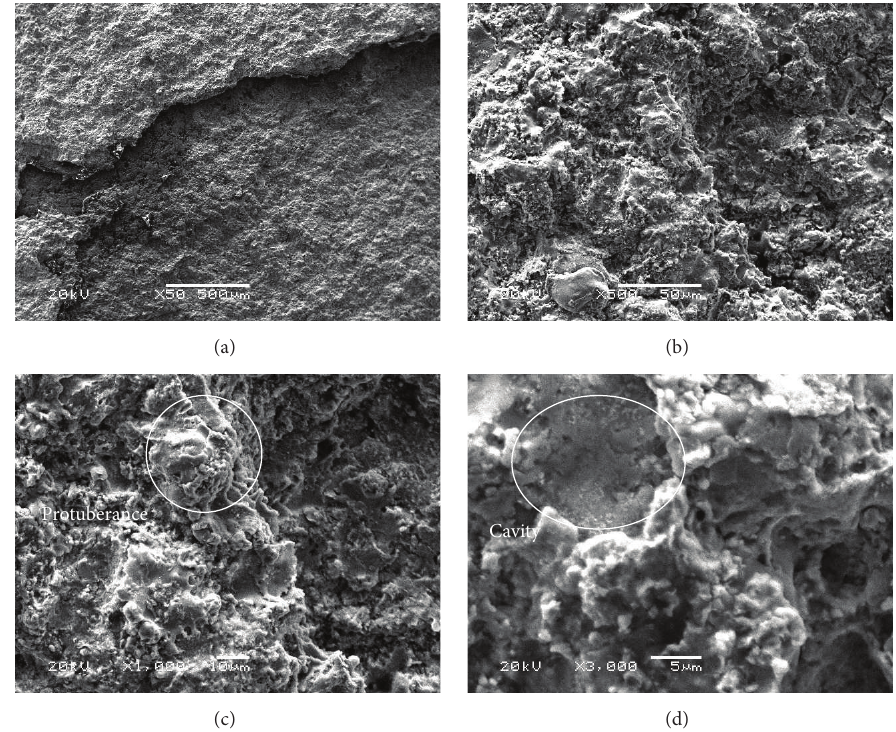
Figure 9: Fractured surface morphologies of as-sprayed coating after the tensile adhesive test. (a) Macrograph of fractured surface; (b) micrograph of fractured surface; (c), (d) high